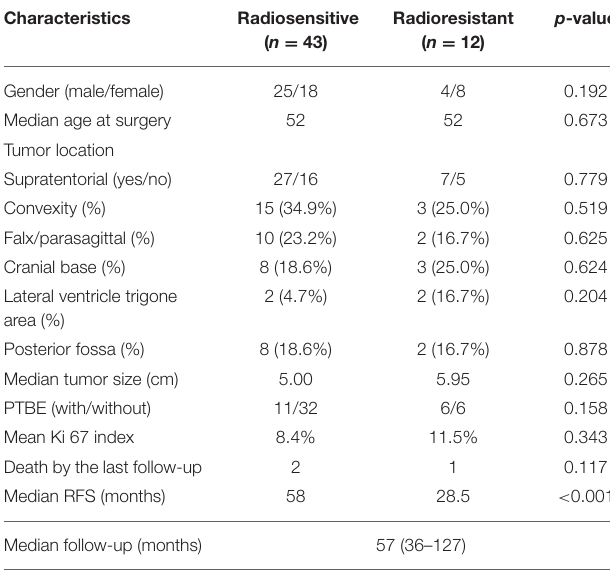
TABLE 1 | Clinical characteristics of the atypical meningioma patients with adjuvant radiotherapy after gross total resection.